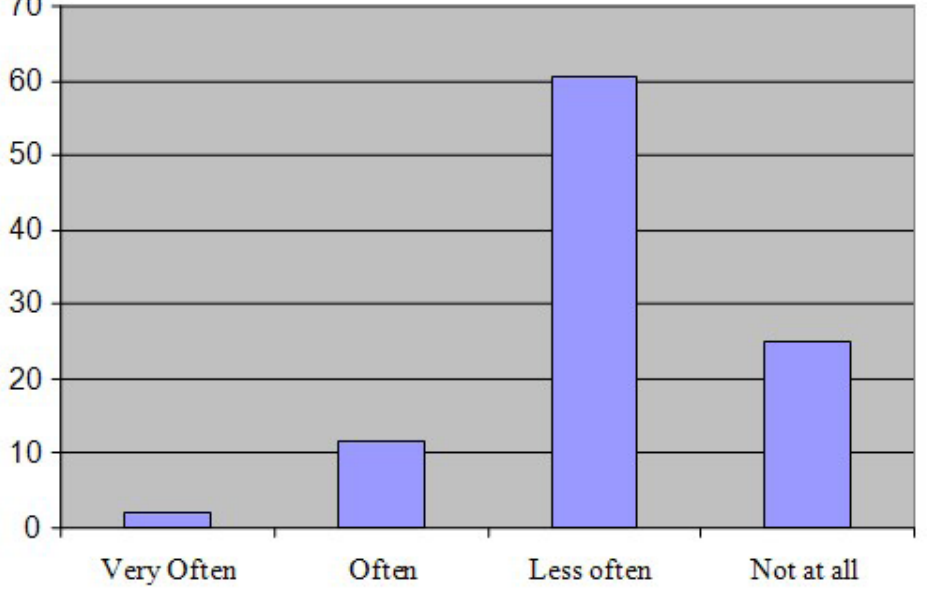
Figure 1 . Student opinion on ODeL evaluation